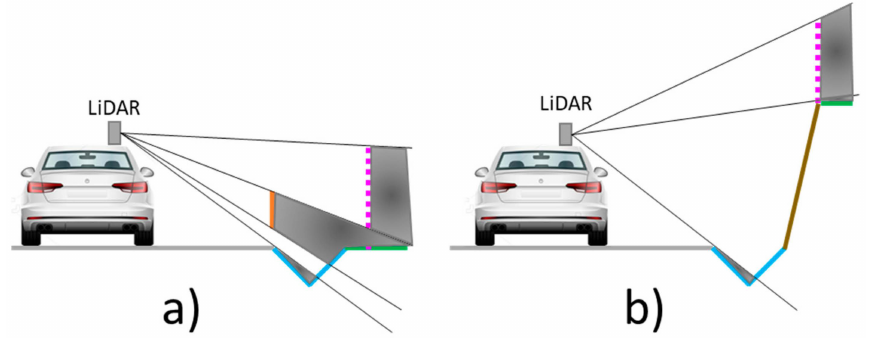
Figure 2. Occlusions in road elements caused by LiDAR position in roads with guardrail ( a ) and with embankments ( b ).